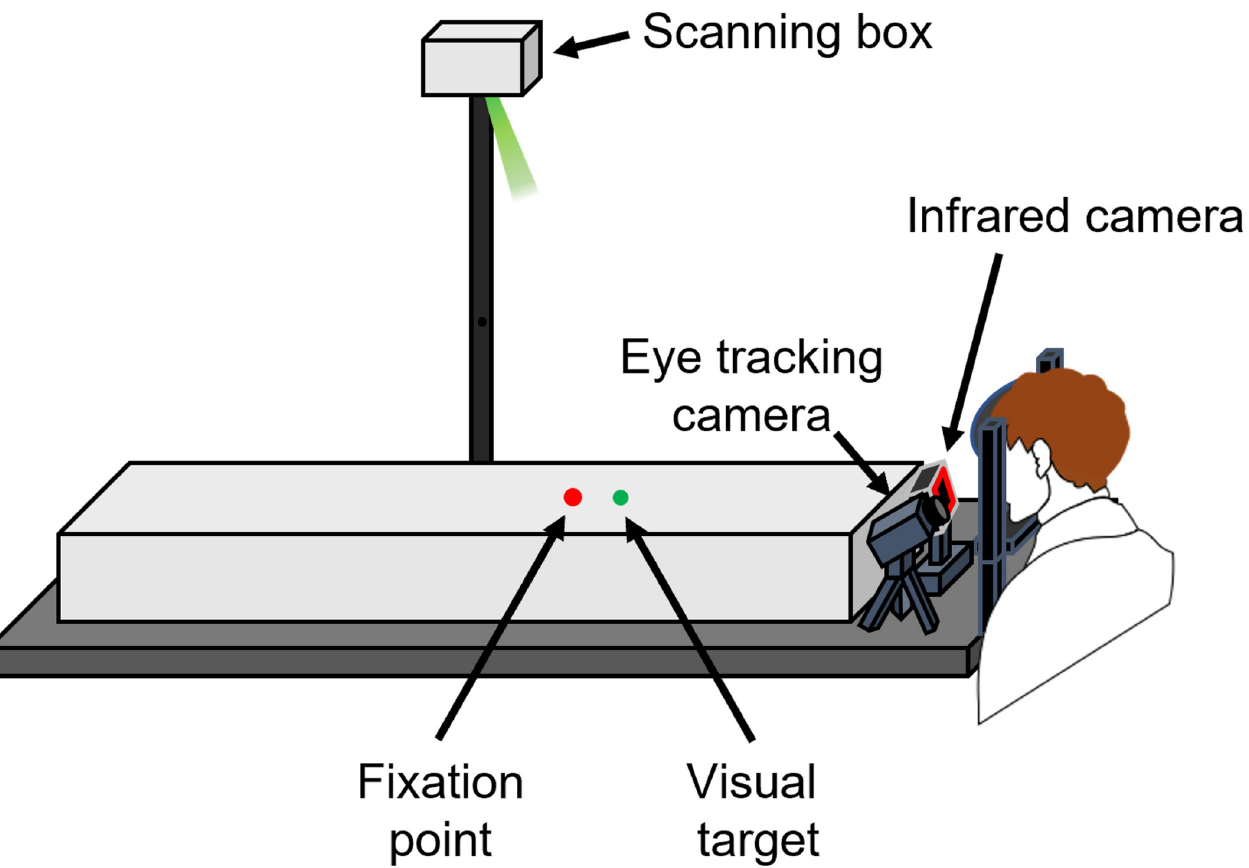
Fig 1. The experimental condition for speed perception tasks. Visual stimuli were moved from far to near and eye movements during the task were measured.